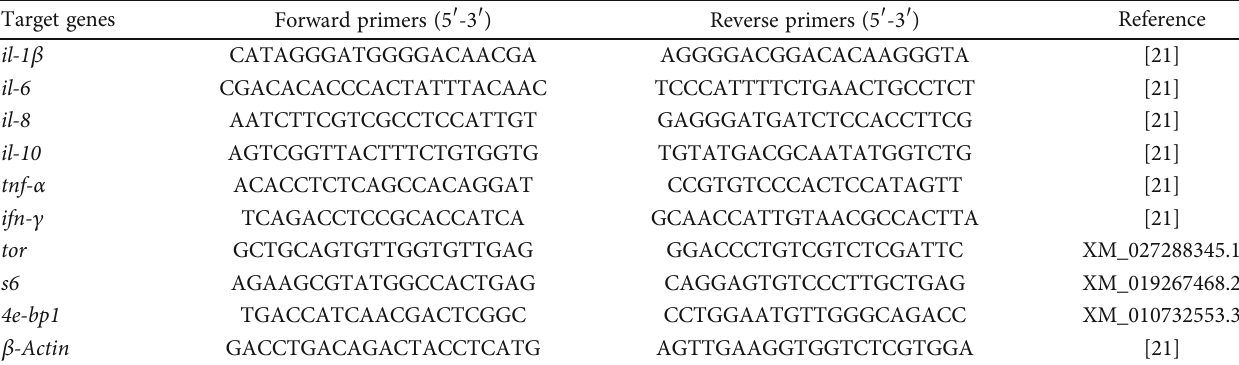
Table 2: Primer sequences used for RT-qPCR in the present study 1